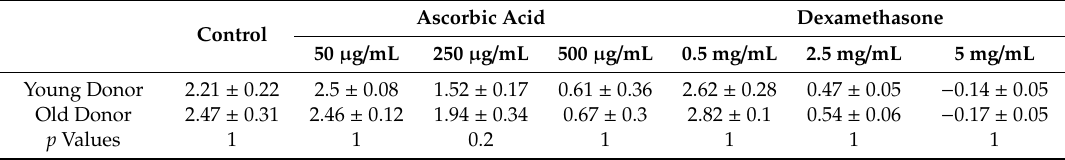
Figure 4. Real-time changes of cell index when tenocytes were exposed to different concentrations of dexamethasone. ( a ) Cell index when tenocytes were exposed to 0.5, 2.5, and 5 mg/mL dexamethasone in the 20-year-old patient. ( b ) Cell index when tenocytes were exposed to 0.5, 2.5, and 5 mg/mL dexamethasone in the 41-year-old patient. * p < 0.05. Table 1. Cell index at 190 h when tenocytes were exposed to ascorbic acid and dexamethasone in young and old donors.